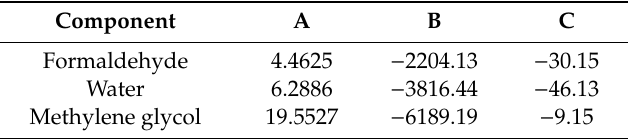
Table 2. Pure component vapor pressure.